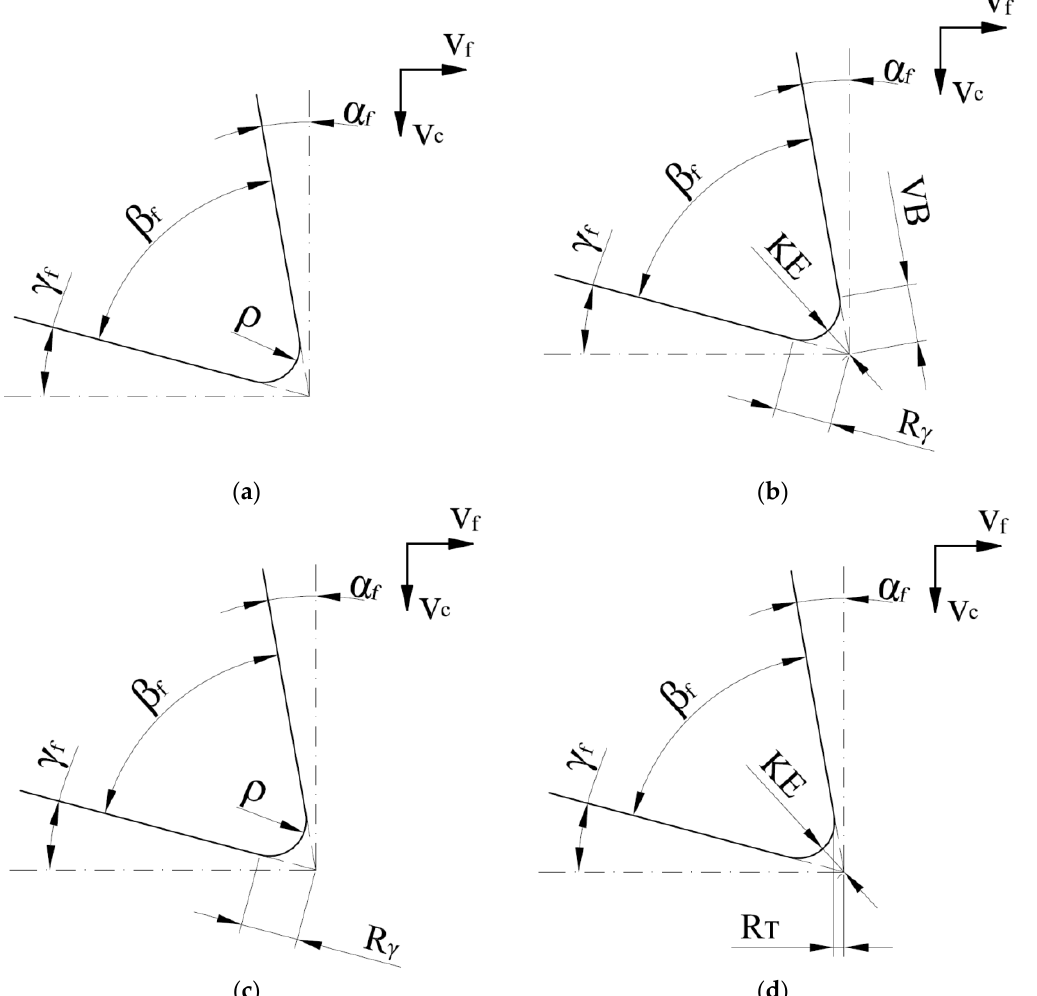
Figure 1. The blunt cutting edge parameters: ( a ) radius of the cutting edge ρ ; ( b ) radial displacement of the tool corner KE, recessions on the flank VB and rake face R γ ; ( c ) radius of the cutting edge ρ and recession of the rake face R γ ; and ( d ) radial displacement of the tool corner KE and recession in tangential direction R T ; Other symbols: γ f —tool side rake angle; α f —tool side clearance angle; β f —tool side wedge angle; v c —cutting speed; v f —feed speed.